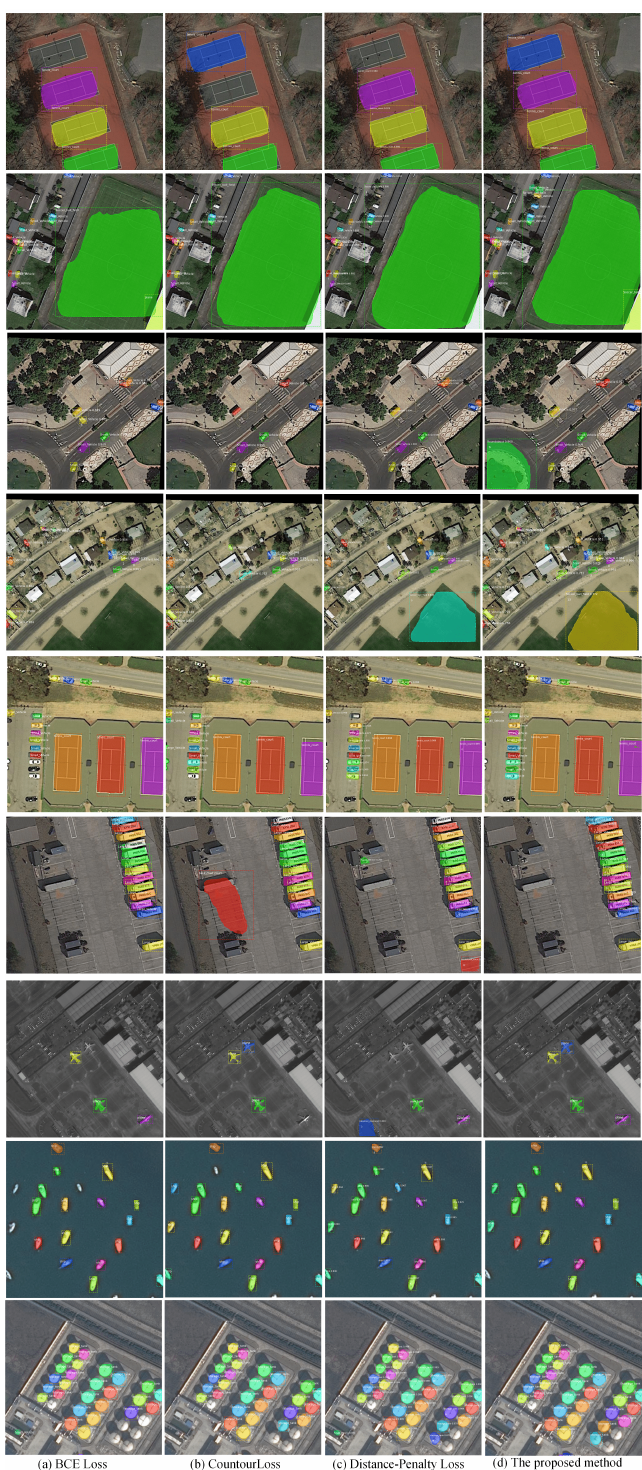
Figure 7. Instance segmentation results of Mask R-CNN trained with BCE Loss, ContourLoss, Distance-Penalty Loss and the proposed